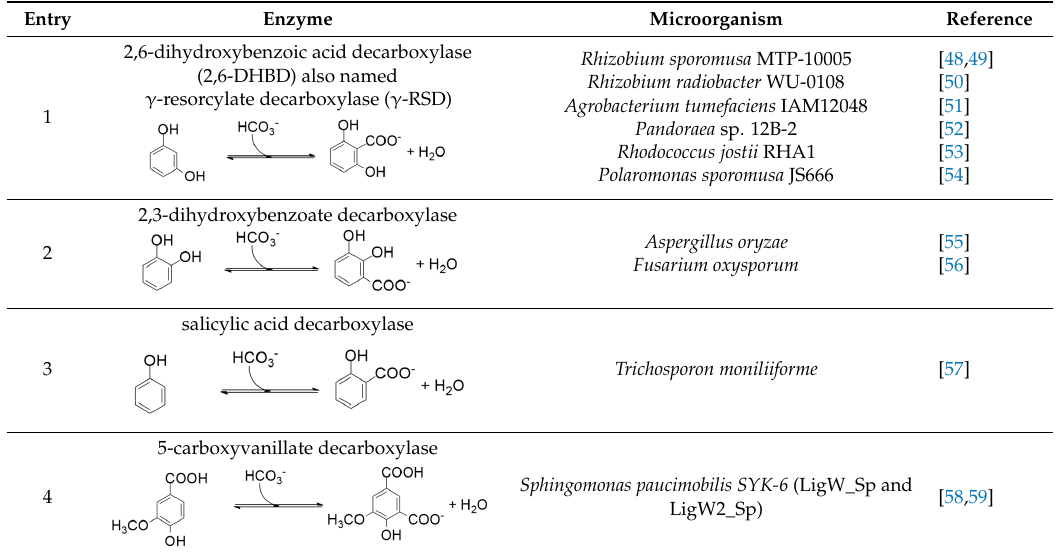
Table 2. List of decarboxylase enzymes catalyzing selective ortho -carboxylation reactions recently characterized.